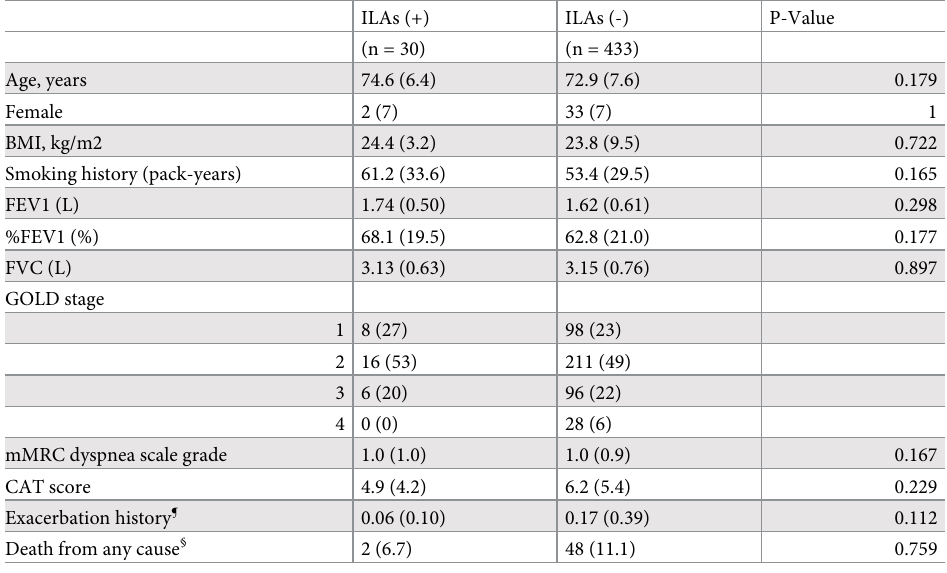
Table 2. Characteristics of the study patients with and without ILAs before 1-to-3 propensity score